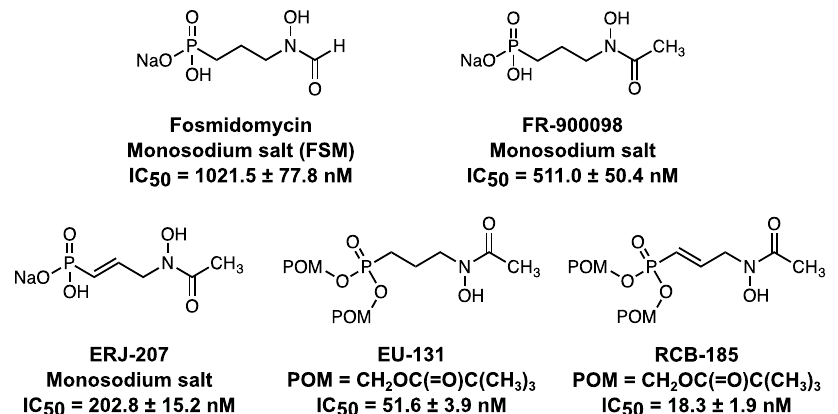
Figure 1. Dxr inhibitors tested against P. falciparum . Displayed are the structures and IC 50 values (mean ± SEM) against P. falciparum strain 3D7 from 9 or more independent